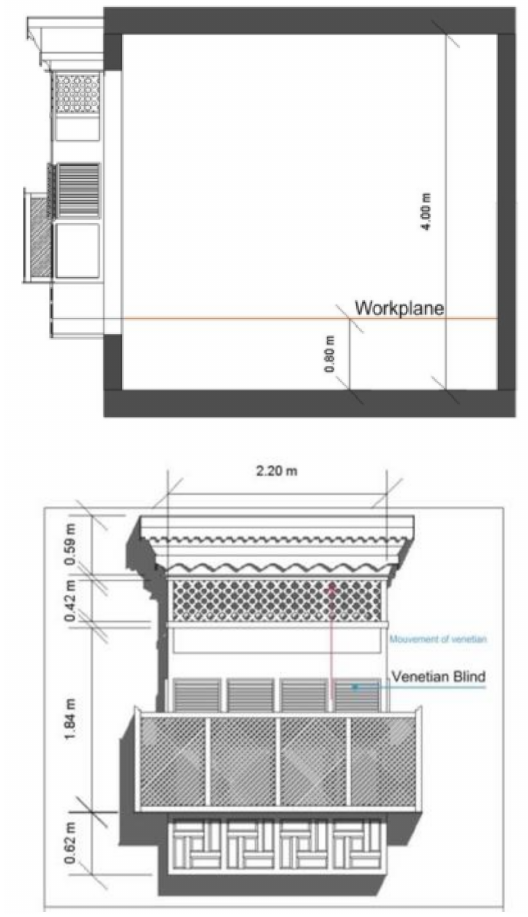
Figure 6. The evaluated room and mashrabiya dimensions. Reproduced from Al-Hashimi and Semidor